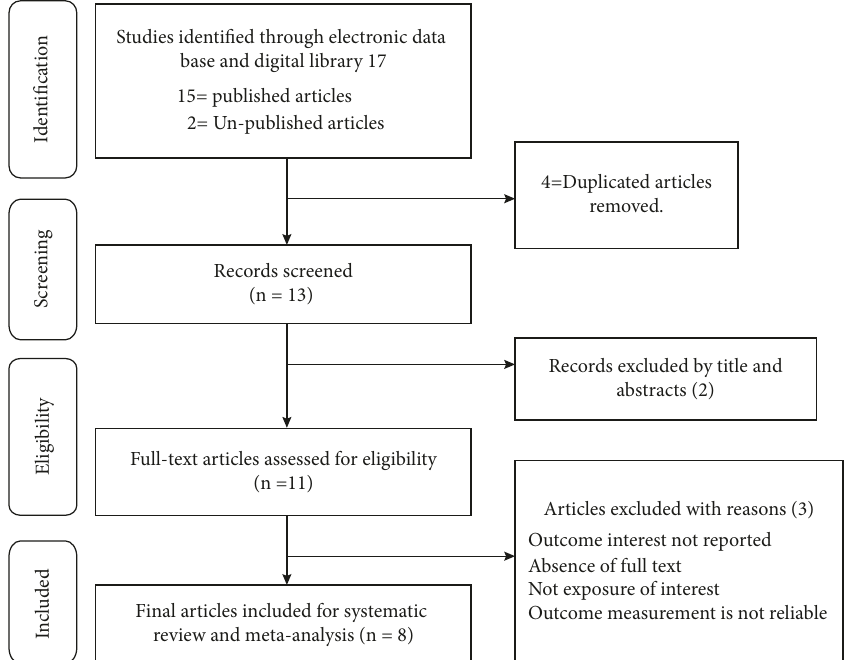
Figure 1: Flow diagram showing the findings of the systematic search and the criteria for